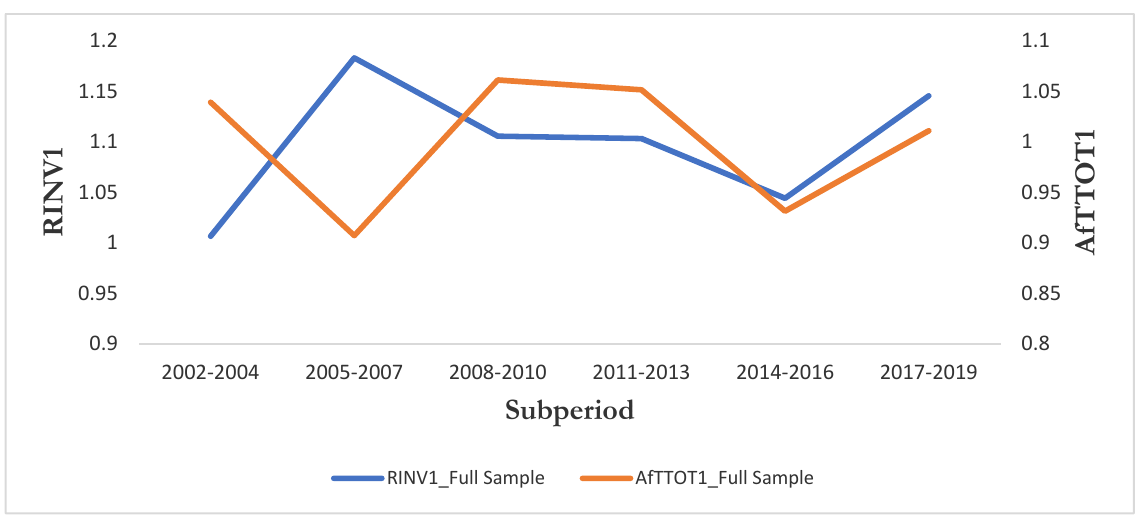
Figure 1. Total AfT flows and investment-oriented remittance flows over the full sample. Source: Author. Note: The variables “RINV1” and “AfTTOT1” are respectively the share of remittance-oriented investment flows in GDP and the share of total AfT flows in GDP, both expressed in percentages, for the sake of the graphical analysis.